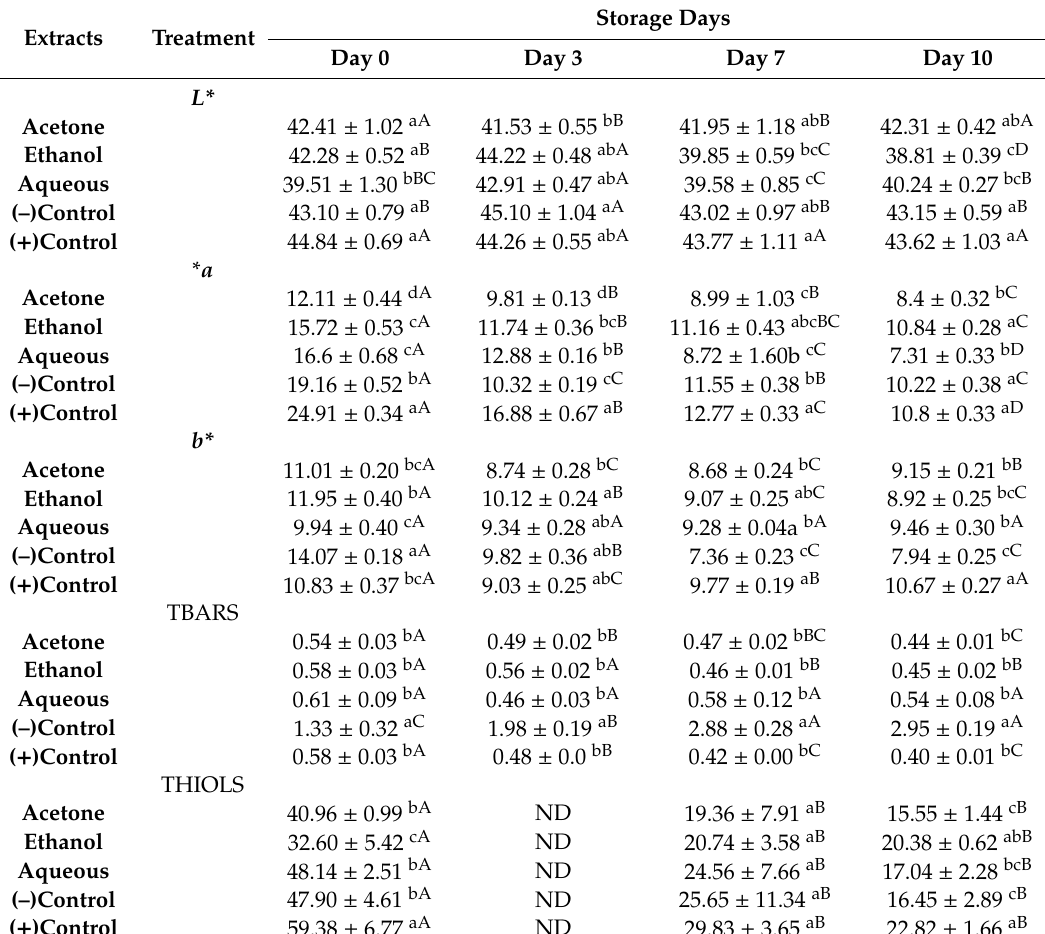
Table 4. Effect of Oudneya africana leaves extracts (0.03%) and commercial mix (2%) on color ( L* , a* and b* ), lipid oxidation (TBARS expressed in mg MDA / kg samples) and protein thiol loss (expressed in nmol / mg protein) in beef burgers stored at 4 ◦ C during 10